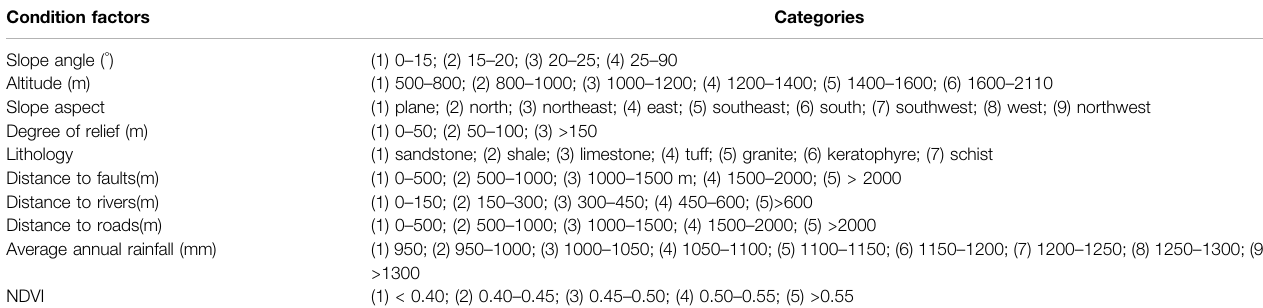
Table 4 , which is consistent with the conclusions obtained